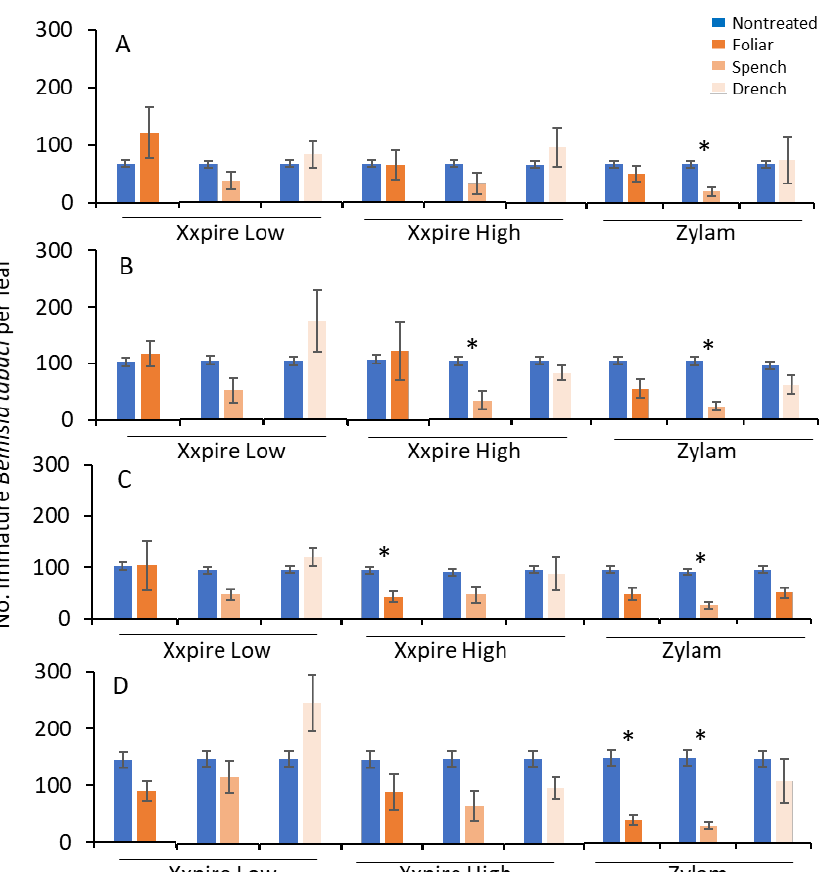
Figure 4. All instars of B. tabaci (mean ( ± SE)) observed on poinsettia leaves treated on insecticide– method combination treatments compared with nontreated check treatment in the greenhouse at ( A ) 7, ( B ) 14, ( C ) 21 and ( D ) 28 days after application. The asterisks (*) indicate the significant differ- ence between specific insecticide–method combination treatment and nontreated check treatment (Student’s t -test; α = 0.05 ).